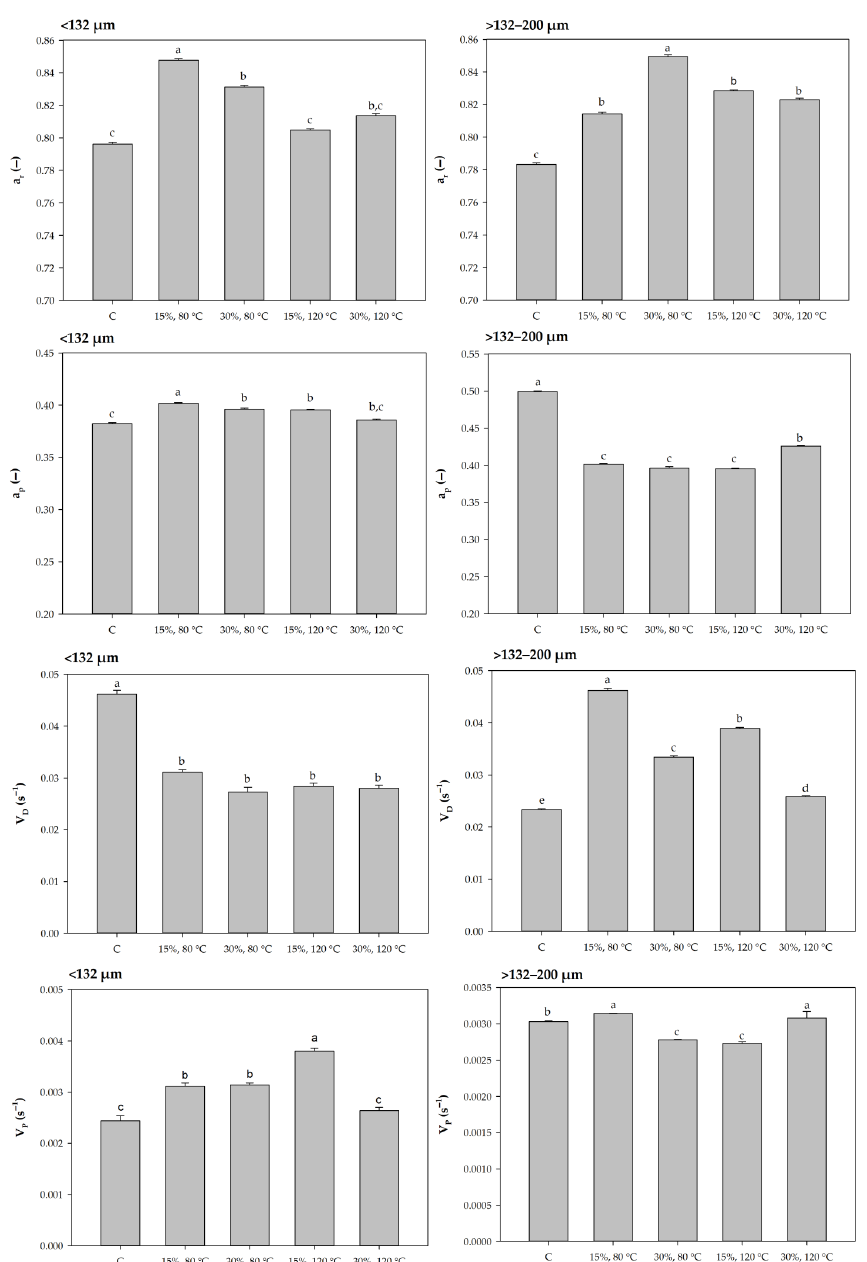
Figure 1. Results of equilibrium value (a r ) and limit water activity (a p ), as well as transport rate (V D ) and rate of the surface conduction (V P ) of water.